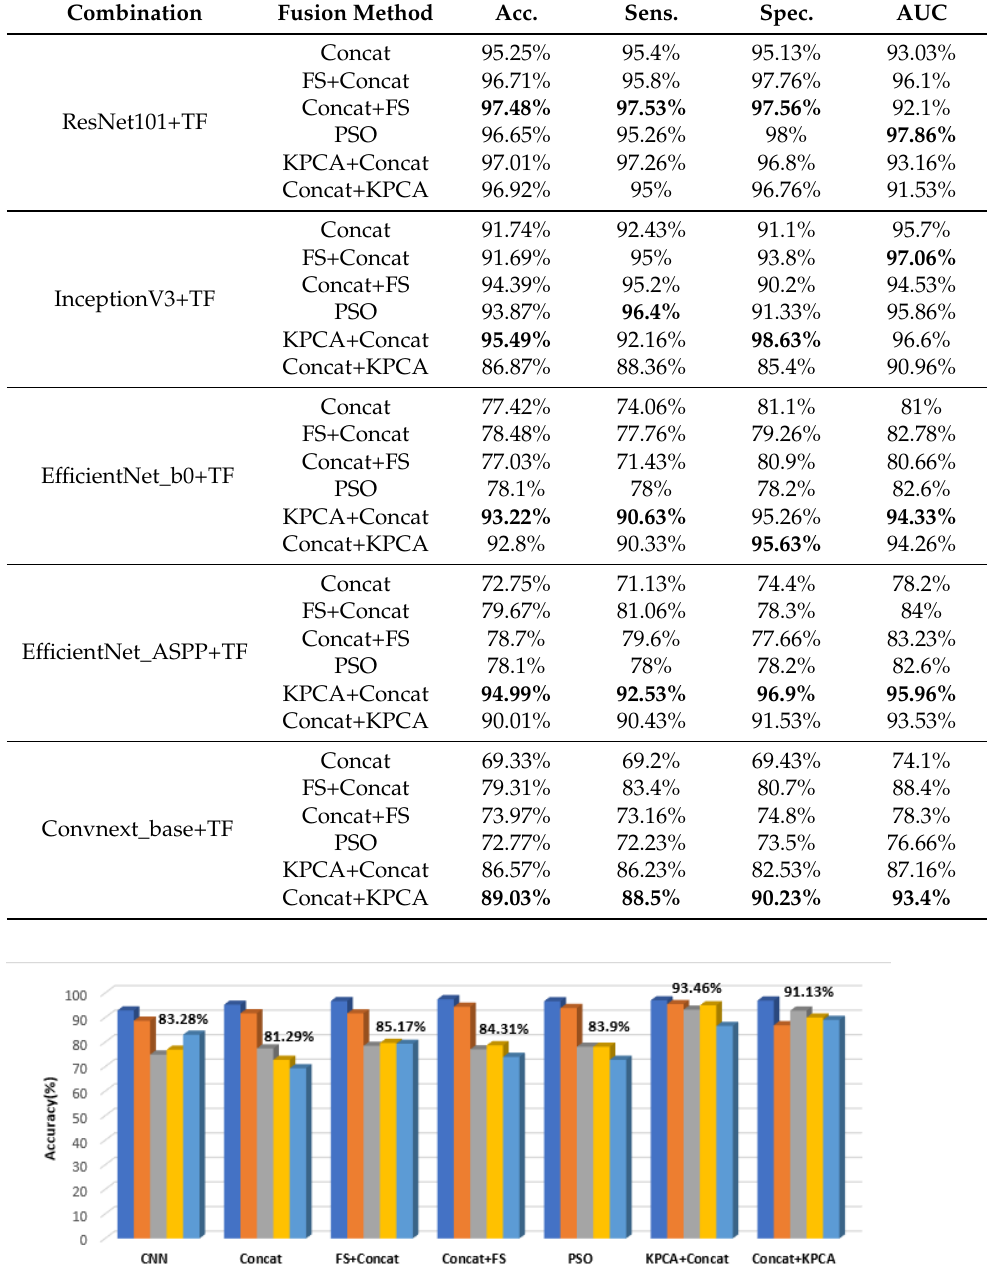
Table 6. Results obtained on GE7 through various combination methods.